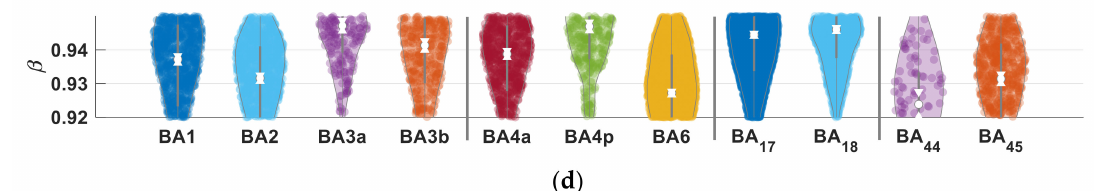
Figure 8. Violin plots for α and β including notches at the ( p < 0.05) significance level across the 11 cortical regions considered. The headings identify different cortical areas consisting of different regions, for example, the adjacent cortical areas BA17 and BA18 in the visual cortex have been evaluated. The time fractional Bloch model parameter ( a , b ) α was not able to discern regions ( p < 0.05) in the visual and Broca cortical regions, whereas ( c , d ) β had significant differences between sub-regions in the four cortical regions evaluated.